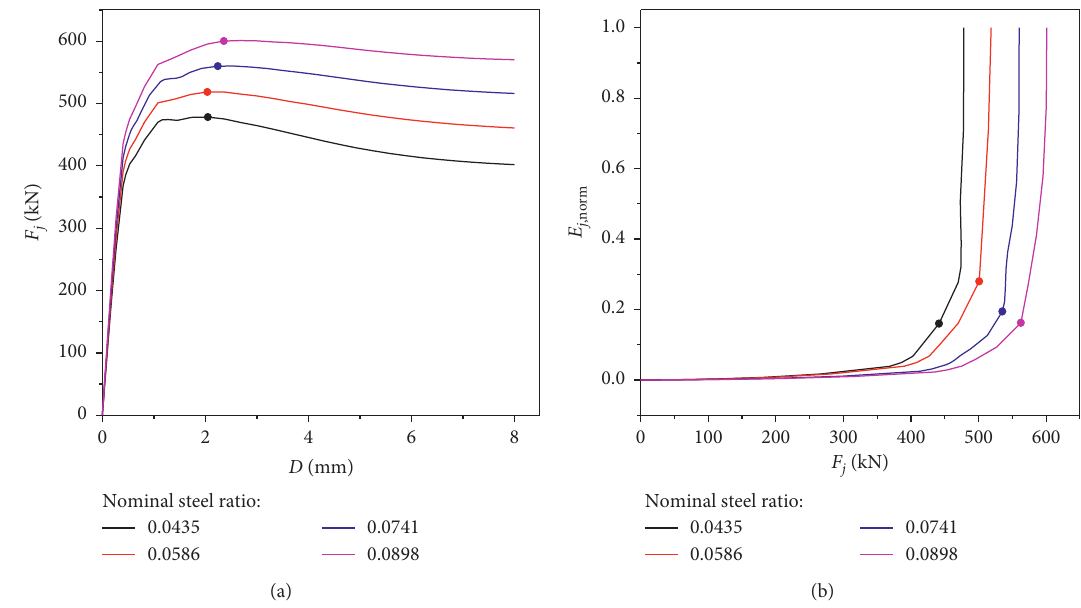
Figure 12: (a) F − D curves of different nominal steel ratio, (b) E j